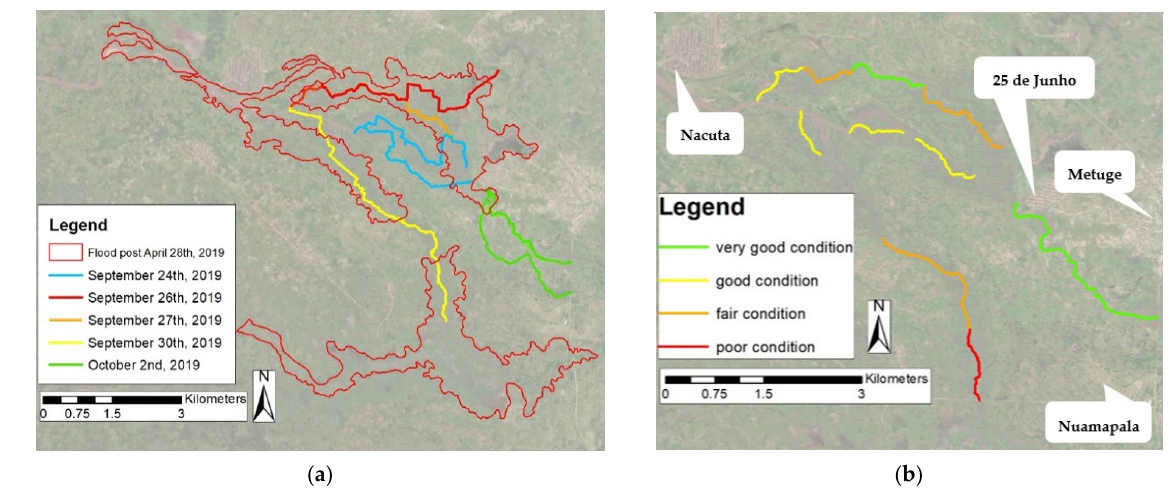
Figure 2. ( a ) Routes tracked during the field survey and contour of the flooded area obtained from satellite images taken after cyclone Kenneth (28 April 2019; Kenneth reached its peak intensity on 25 April). ( b ) Map of the sub-reach classification.